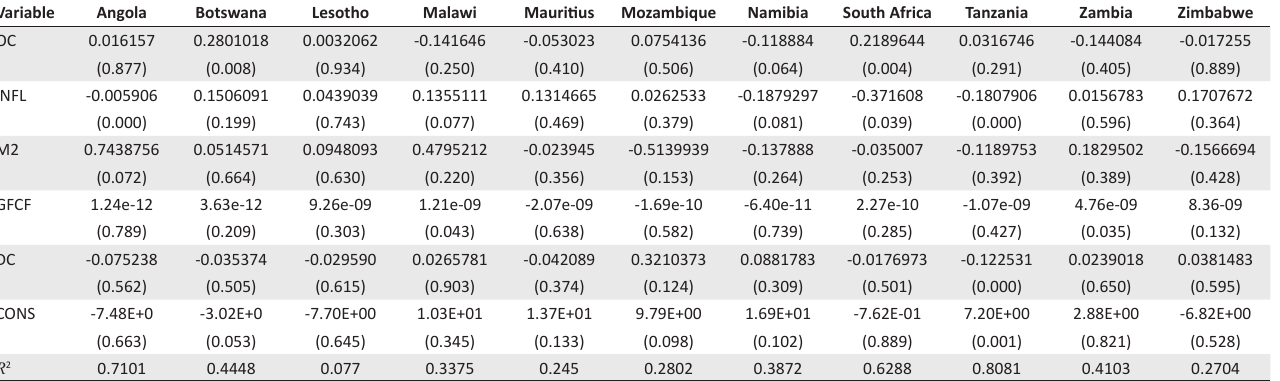
TABLE 6: Seemingly unrelated regression estimators results. Variable